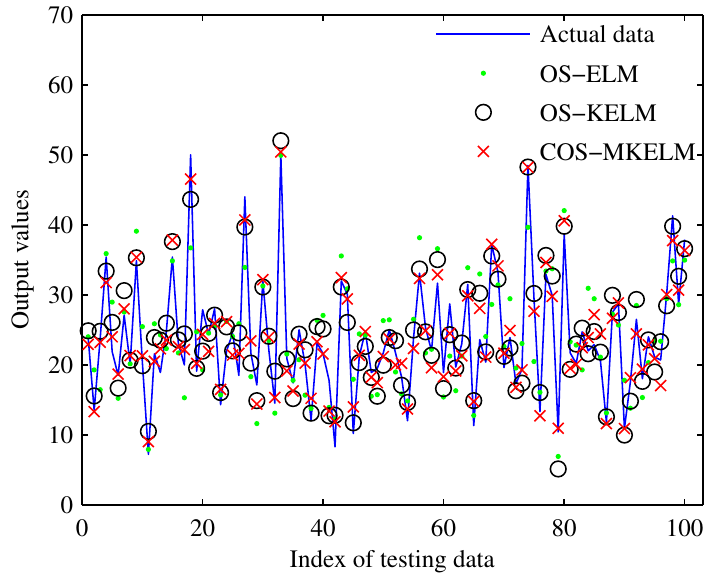
Figure 3. Output values for testing data of d 3